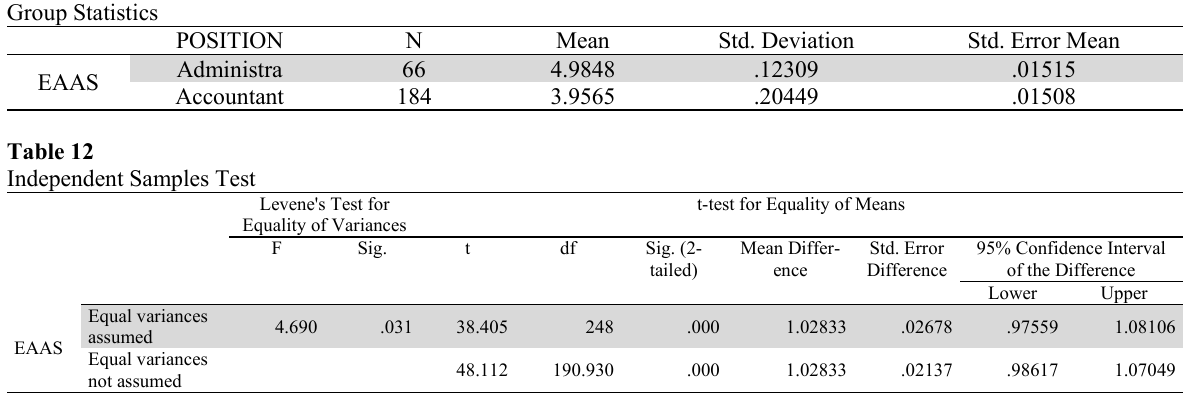
Group Statistics